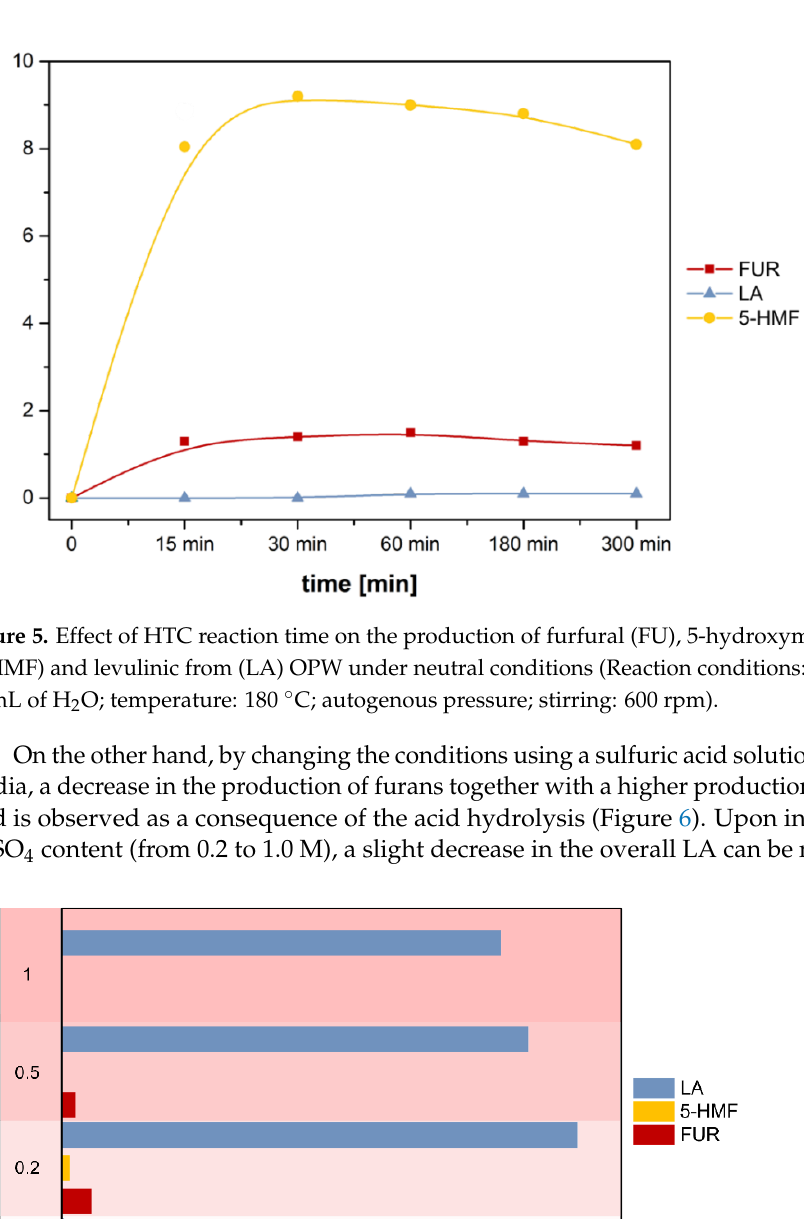
Figure 7. Co-solvent effect of HTC reaction temperature on the production of alkyl levulinates (Re- action conditions: 20 g of OPW; temperature: 180 °C; time: 60 min; autogenous pressure; stirring: 600 rpm).